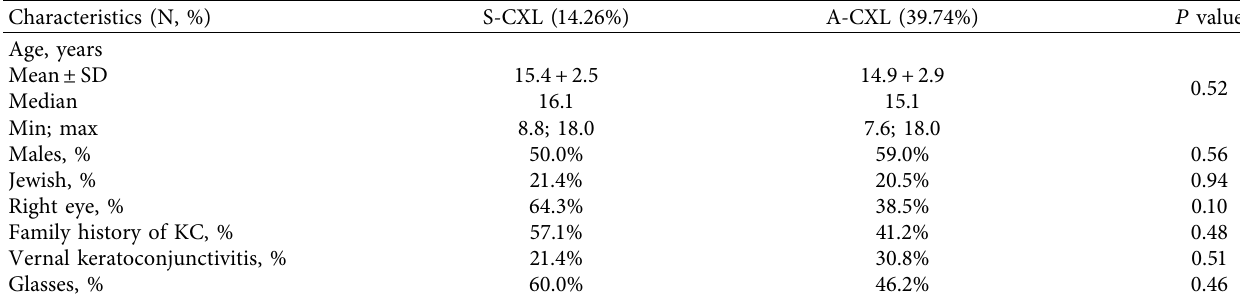
Table 1: Demographic and clinical characteristics of the study population.